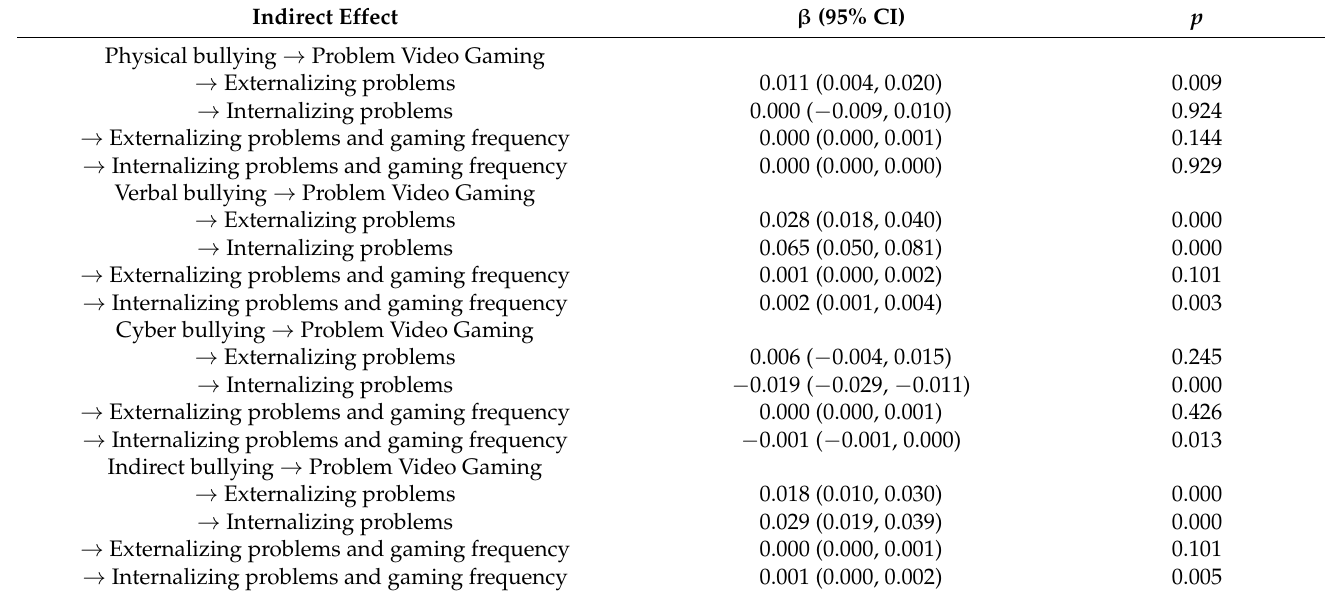
Figure 1. Parallel-serial mediation model whereby externalizing and internalizing problems mediate the relationship between physical, verbal, cyber and indirect bullying and gaming frequency, and gaming frequency mediating the relationship between externalizing and internalizing problems and severity of problem video gaming. All estimates are standardized with 95% confidence intervals in parentheses. Dashed lines were estimated but non-significant ( p > 0.05). * p < 0.05; ** p < 0.01; *** p < 0.001. Table 3. Indirect effects from the parallel-serial mediation model.